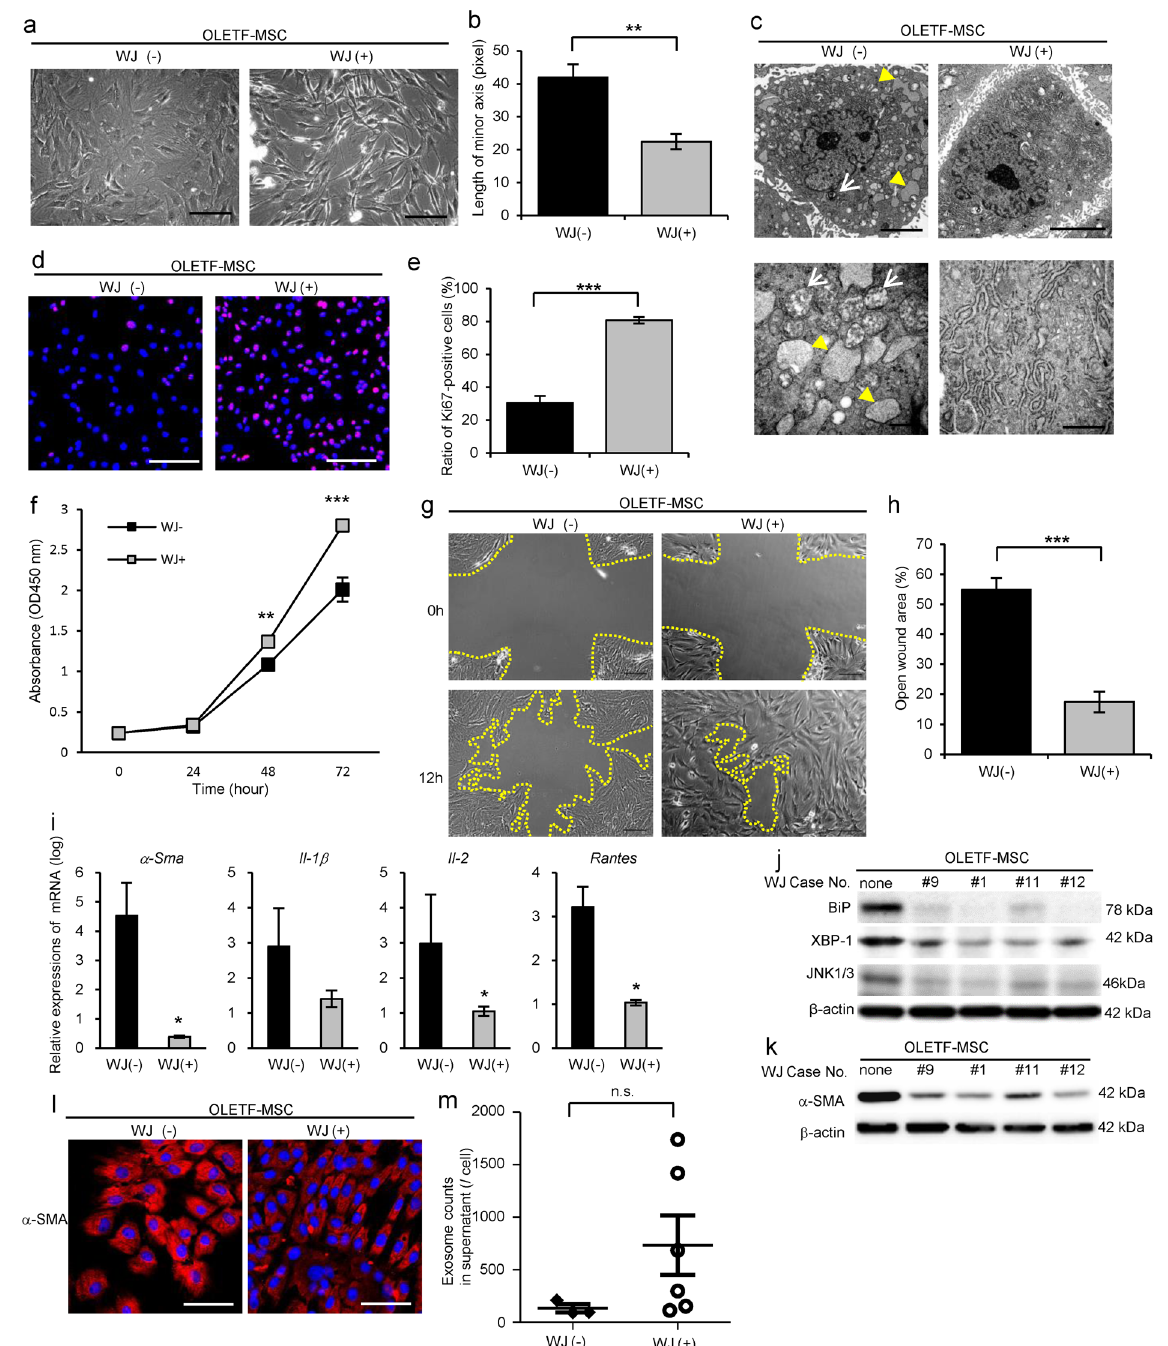
Figure 6. Activating effects of WJs for OLETF-MSC. ( a ) Phase contrast images of OLETF-MSC. Bar: 100 µ m. ( b ) The average length of the minor axis of cells in phase contrast images were measured in all cells in five panels of each OLETF-MSC. N = 5, each. ** P < 0.01. ( c ) TEM images of OLETF-MSC. White arrows show mitochondria degenerations. Yellow arrowheads show abnormal dilation of the ER. Bar: 5 µ m in upper panels and 500 nm in lower panels. ( d ) Immunofluorescence staining of OLETF-MSC with Ki-67 antibody (red). Nuclei counterstained with DAPI (blue). Bar: 100 µ m. ( e ) The average ratio of Ki-67-positive cells to total cell count in five panels of each OLETF-MSC. N = 3, each. *** P < 0.001. ( f ) MTT proliferation assays of OLETF- MSC. Absorbance at 450 nm was measured 0, 24, 48 and 72 hours after the MTT addition. WJ( − ); n = 5, WJ( + ); n = 15. ** P < 0.01, *** P < 0.001. ( g ) Scratch assay of OLETF-MSC. The open wound area was measured immediately and 12 hours after performing the cross-scratch. Yellow lines indicate the cell mobilization edge. ( h ) Quantitative analysis of the ratio of open area at 12 hours compared with 0 hours, measured in five cross- scratch points in each OLETF-MSC. N = 3, each. *** P < 0.001. ( i ) Relative expressions of mRNA in OLETF- MSC. WJ( − ); n = 4, WJ( + ); n = 10. * P < 0.05. ( j ) Western blot analysis of OLETF-MSC which are cultured with WJs (lots #9, #1, #11, #12) or without WJs using anti-BiP, anti-XBP-1, anti-JNK1/3 and β -actin antibodies.